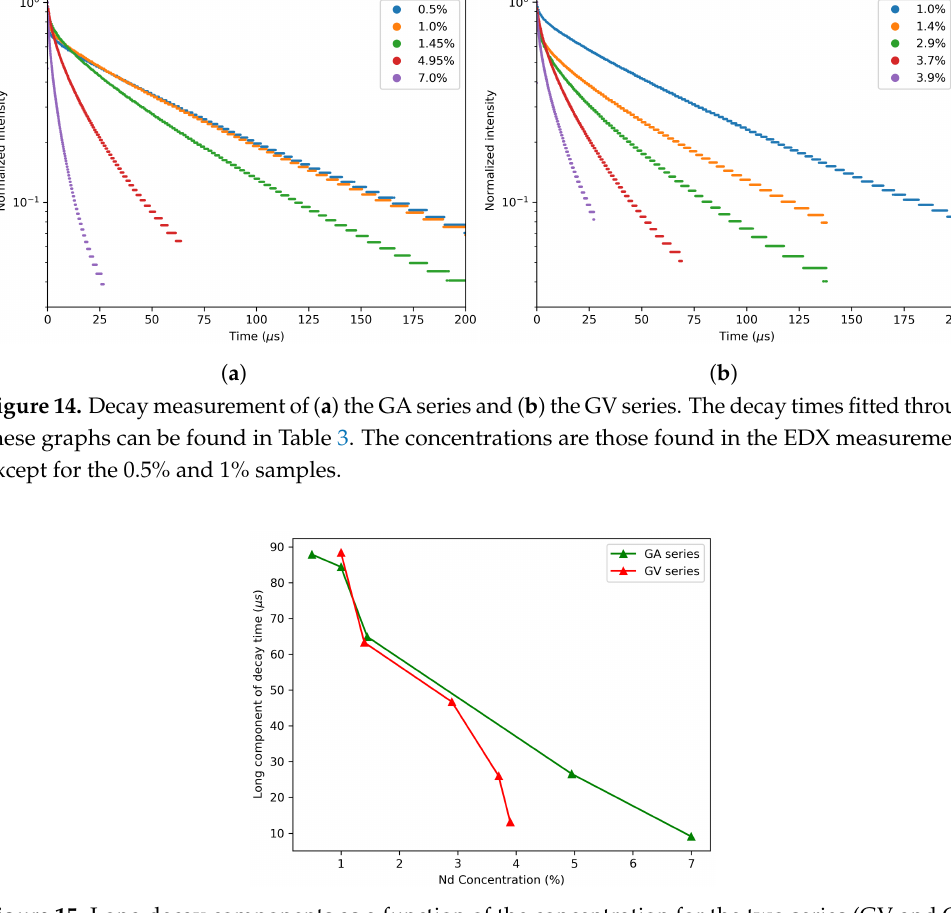
Figure 15. Long decay components as a function of the concentration for the two series (GV and GA) as a function of Nd concentration. The concentrations are those found in the EDX measurements except for the 0.5% and both 1%